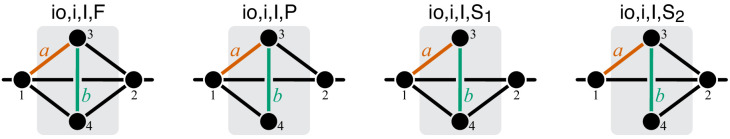
Graphical representation of strictly serial and strictly parallel generating topologies in class Mio,i,I.Fully connected topology io,i,I,F is shown for reference (same as in Figure 8).